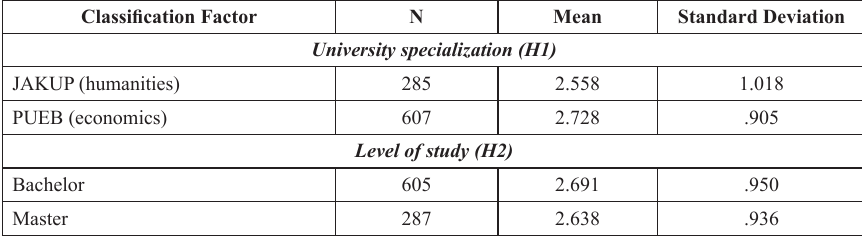
Table 6. Descriptive statistics – distance learning as an alternative to in-person